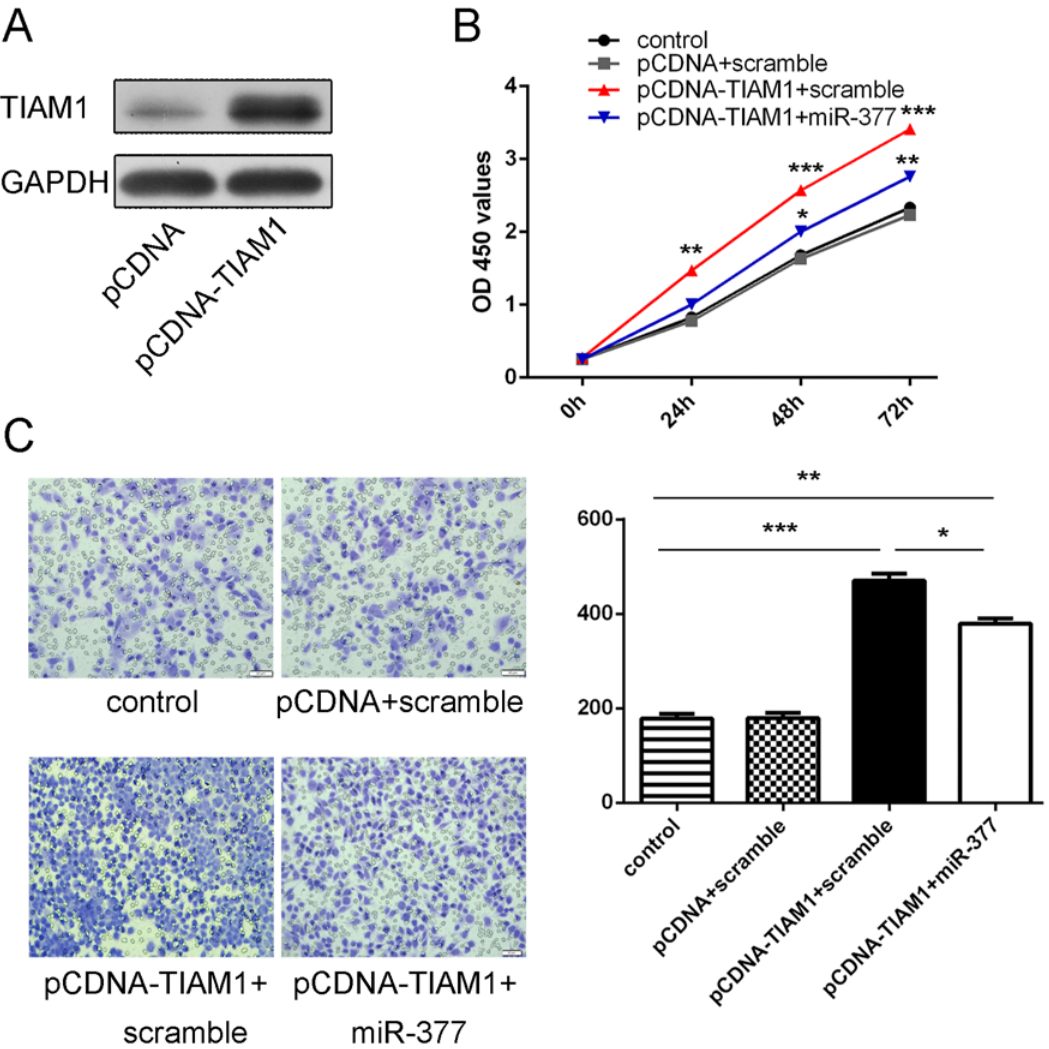
Fig 5. Restoration of miR-377 inhibits TIAM1-mediated HCC cell proliferation and invasion. (A) Western blotting was performed to examine the effects of pCDNA-TIAM1 on the expression of TIAM1. GAPDH was also detected as a loading control. (B) The cell growth in HepG2 co-transfected with either miR- 377 mimic or scramble and 2.0 μ g pCDNA- TIAM1 or pCDNA empty vector using CCK-8 proliferation assay. (C) The cell invasive in HepG2 co-transfected with either miR-377 mimic or scramble and 2.0 μ g pCDNA- TIAM1 or pCDNA empty vector using invasion assay. * p < 0.05, ** p < 0.01, and *** p <